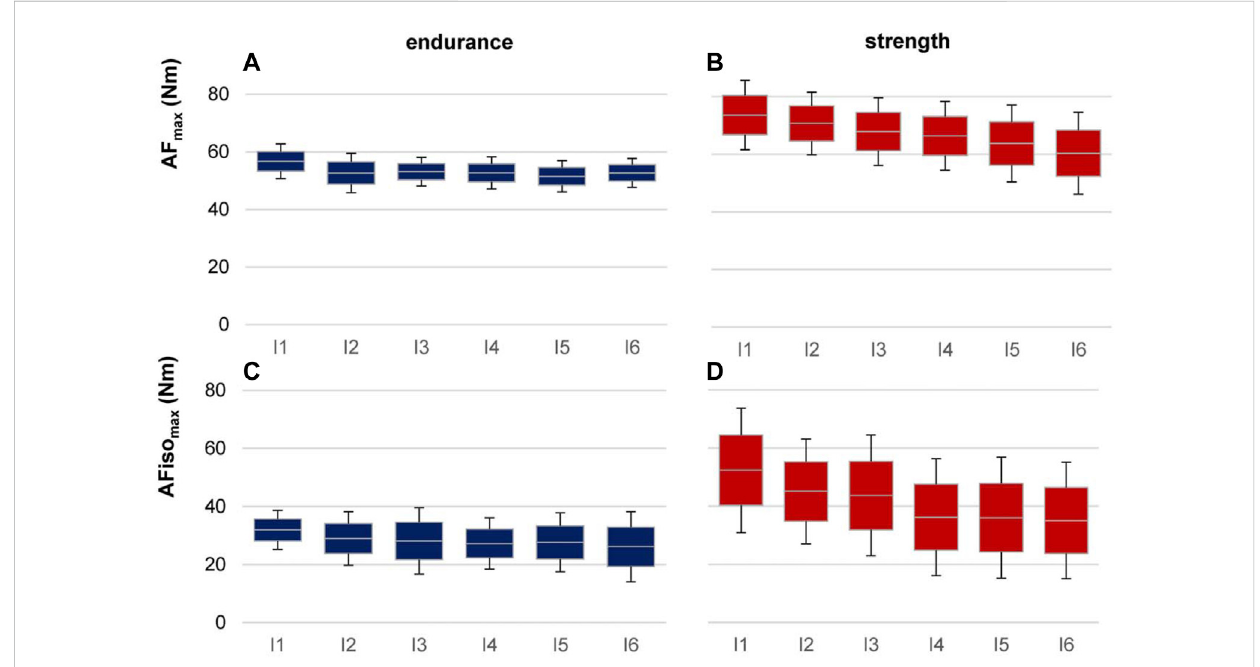
FIGURE 6 AF torques in six intervals for strength vs. endurance athletes. Displayed are the arithmetic means, standard deviations (error bars), and 95% CIs of AF max (A, B) and AFiso max (C, D) for endurance (left, blue, n = 6) and strength (right, red, n = 6) athletes regarding the six intervals of 30 trials (I1 –